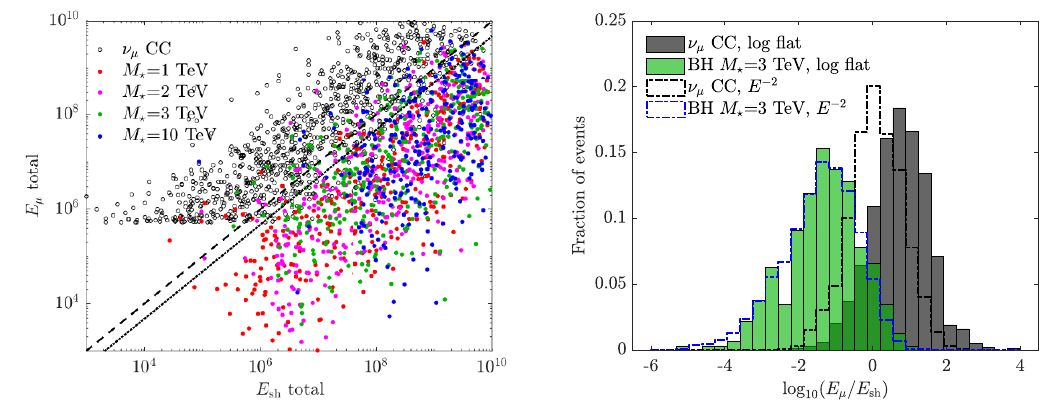
Figure 5 . Left: total energy of muons versus total energy of shower particles in black hole simula- tions (colored dots) and (cid:23) (cid:22) CC events (black circles). Red, magenta, green and blue dots correspond to simulations with M ? =1 TeV, 2 TeV, 3 TeV and 10 TeV, respectively. Simulations assume n = 6 extra dimensions. Lowering n reduces the production cross section but does not a(cid:11)ect the distri- butions. The dashed line depicts where E (cid:22) = E sh , and the dotted line E (cid:22) = 0 : 5 E sh delineates the region in which 90% of (cid:23) (cid:22) CC events are contained. Each case is based on 1000 simulations, sampled (cid:13)atly in log ( E (cid:23) ). We require E (cid:22) > 1 TeV for an event to be considered a track event, and black 10 holes not producing muons are not shown. We also neglect the possible additional contributions from taus as evaporation products (See (cid:12)gure 6). Right: distribution of the ratio log( E (cid:22) =E sh ) in the total muon energy to total shower energy ratio across all energy ranges for CC events (black histogram) and BH events with M ? = 3 TeV (green histogram) which produce muon tracks dur- ing evaporation for log (cid:13)at neutrino (cid:13)ux. Dashed black and blue lines show the distribution of log( E (cid:22) =E sh ) with E (cid:0) 2 spectrum instead and a minimum energy deposition of 20 PeV as described in section 3.1. See section 5 for